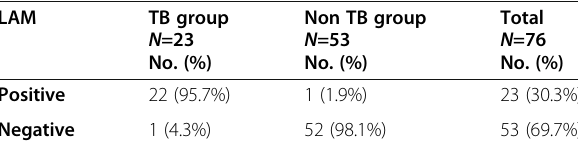
Table 4 Results of LAM test in both groups ( Qualitative LAM analysis